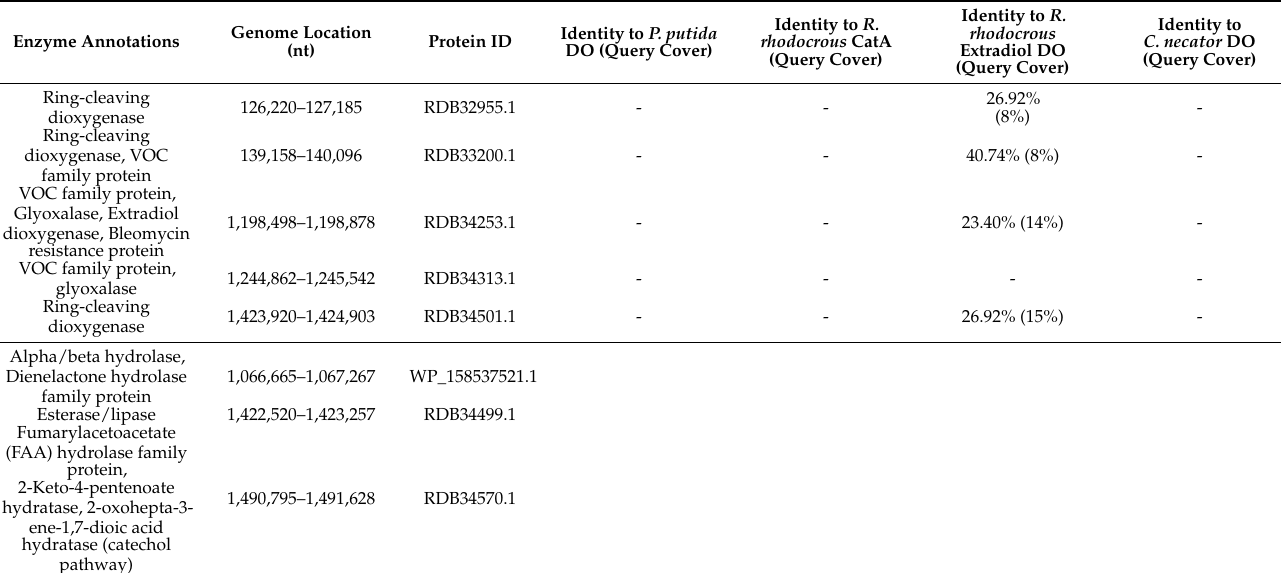
Table 2. Putative orphan proteins involved in PS degradation identified from searches of the genome annotations for Exiguobacterium sp. RIT 594. Comparisons of RIT 594 proteins with proteins attributed to styrene degradation in previously characterized dioxygenases from Pseudomonas putida [18], Rhodocococus rhodocrous [17], and Cupravidus necator [19]. The hydrolases and reductases can de- grade the initial ring-opened products further. The aromatic amino acid hydroxylase is an aromatic ring hydroxylase and could be an unspecific PS depolymerizing enzyme as suggested by other authors